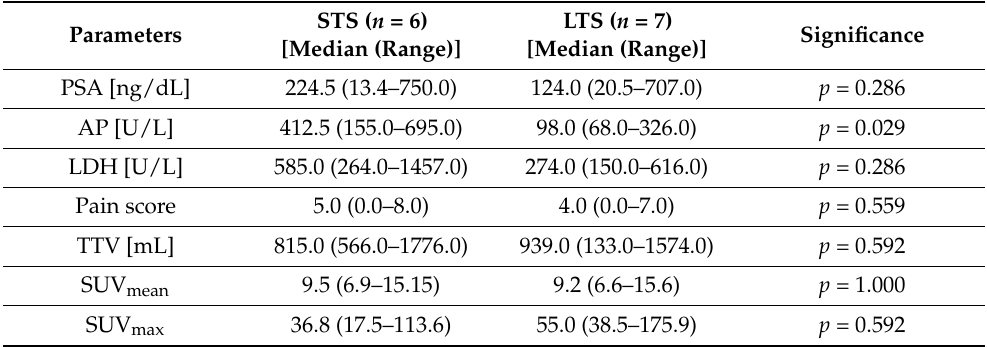
Table 3. Comparison of baseline characteristics between short-term survivors (STS; overall survival (<10 months) compared to patients with an overall survival ≥ 10 months (long-term survivors, LTS) as defined by median split dichotomization.